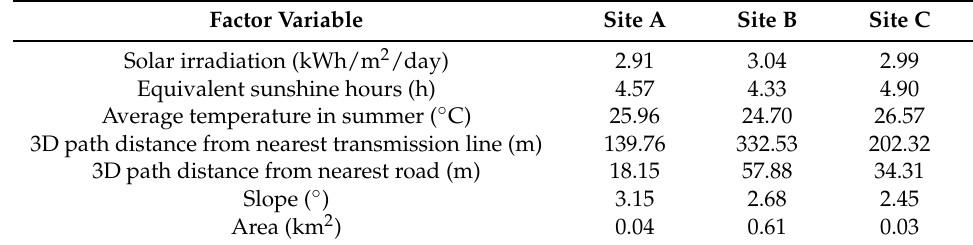
Table 6. Statistical summary of average factor variable values and the areas within the three candidate